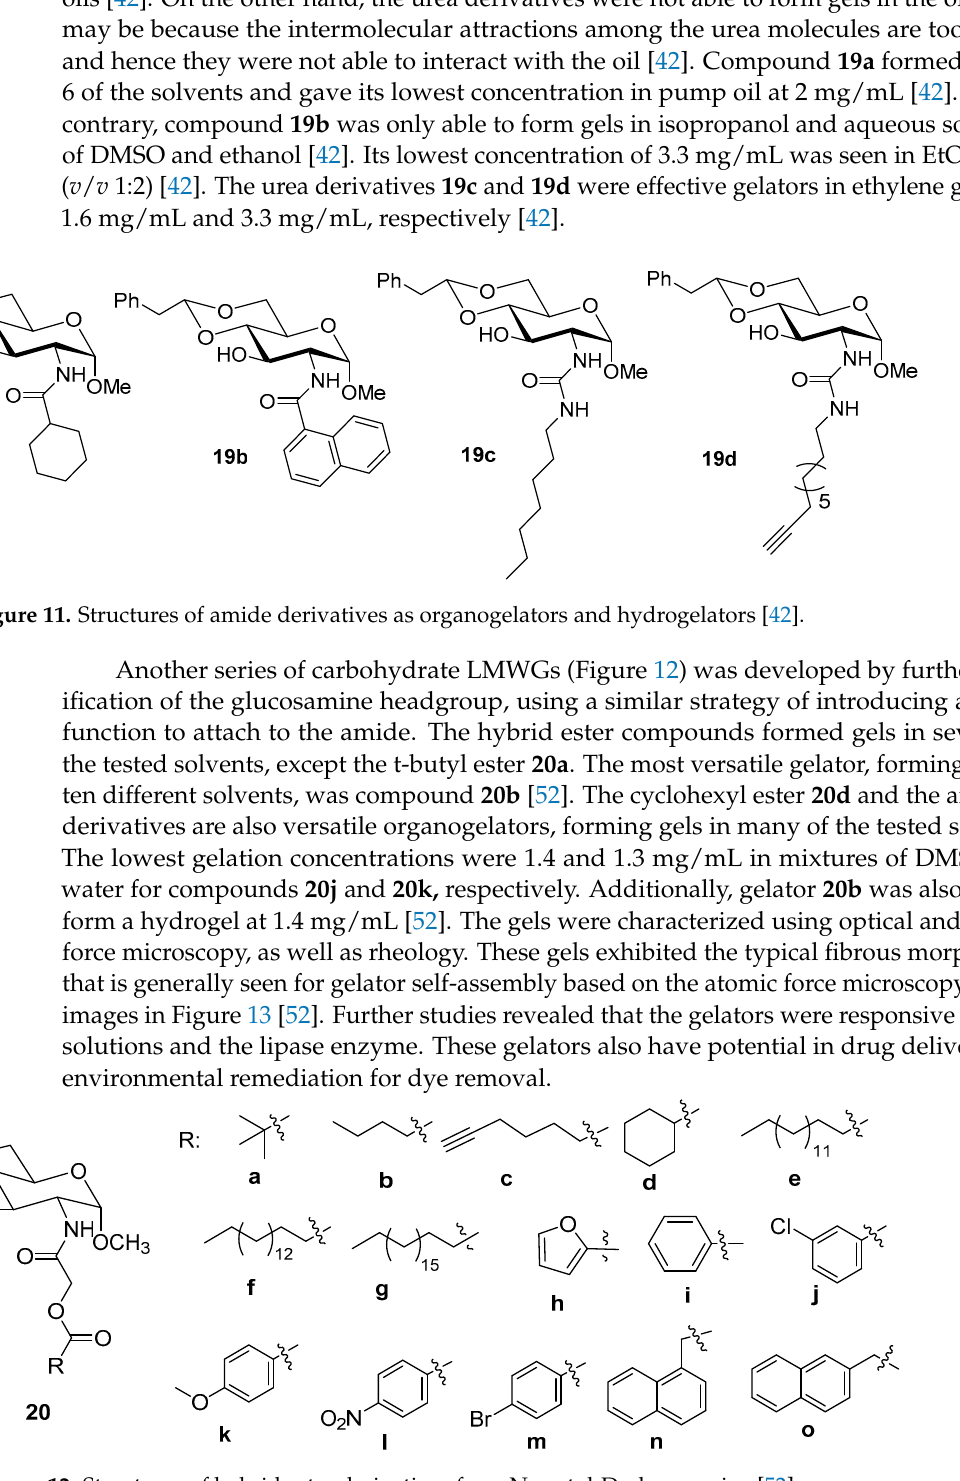
Figure 12. Structures of hybrid ester derivatives from N-acetyl-D-glucosamine [52] .